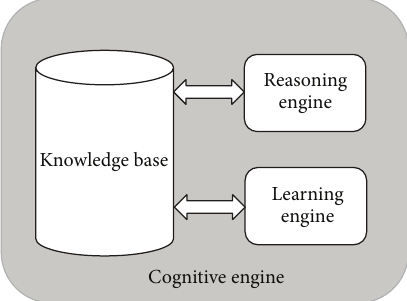
Figure 15: The cognitive engine